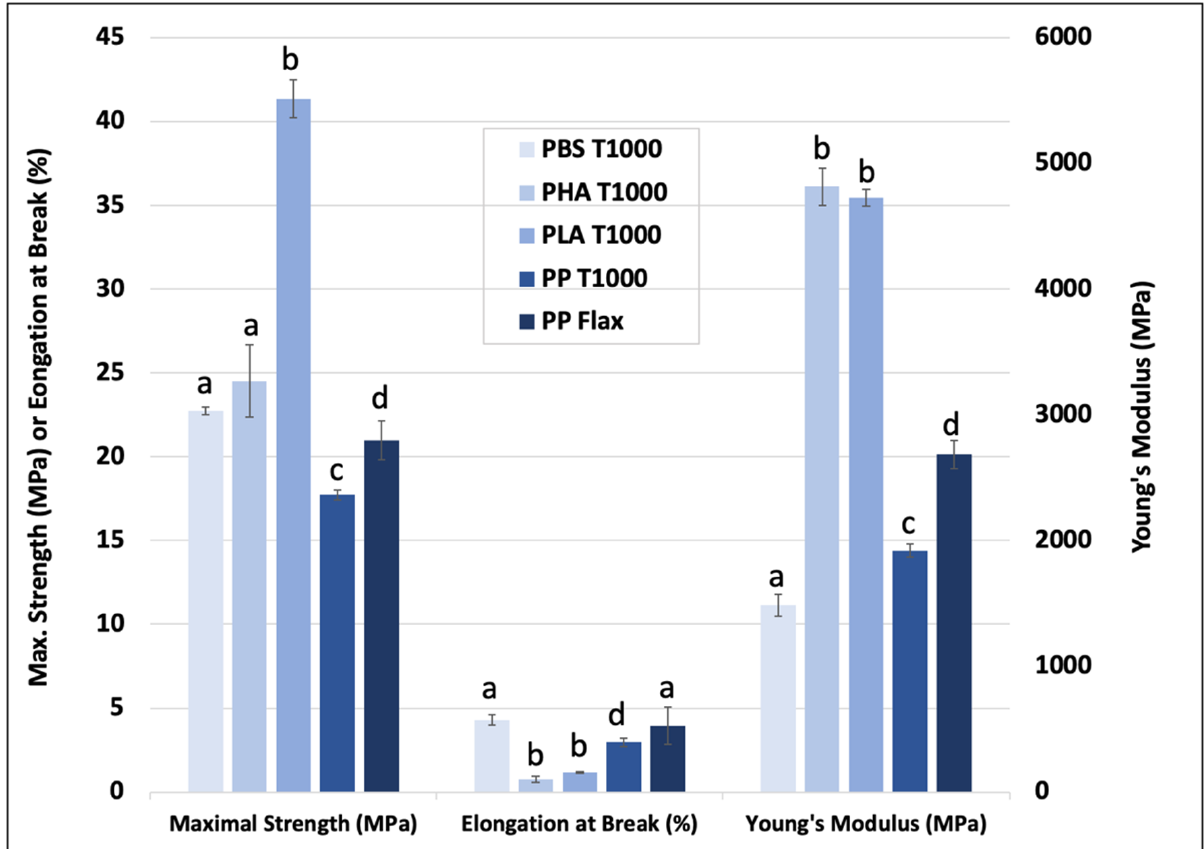
Figure 7. Comparative tensile mechanical properties of PBS–tomato biomass particle composite materials. Letters indicate the statistical differences between the mechanical values. When letters are different, the property is significantly different.